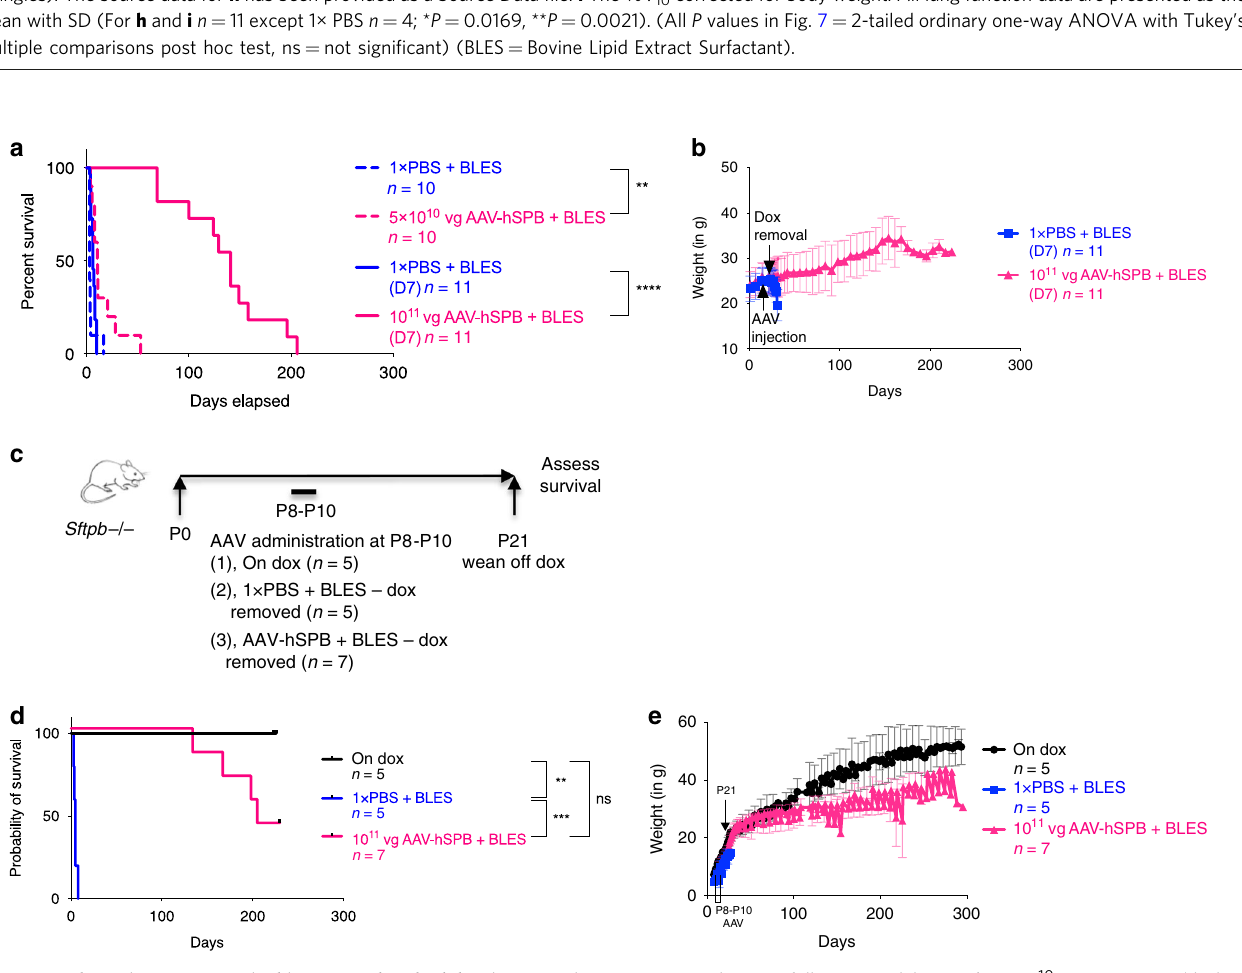
Fig. 7 AAV6.2FF human proSFTPB cDNA (AAV-hSPB) prevents lung damage. a Schematic of the human proSFTPB cDNA transgene in the rAAV2 vector genome. b Study design to determine whether 5 × 10 10 vg per mouse of AAV-hSPB improves lung structure and function in SP-B de fi cient mice. c Percentage change in body weight following AAV injection while still on dox (duration of 28 days). ( n = 11 biologically independent animals per group). d Percentage change in body weight after dox removal (duration of 4 days). All body weight measurements are presented as the mean with SD ( n = 11, except 1 × PBS plus BLES post-dox where n = 4; * P = 0.0221). e Representative gross lung images at harvest 4 days following dox removal. Yellow arrows indicate regions of lung injury. The lung image from the mouse found dead was taken within 24 h of death. f Representative H&E and WGJ staining of